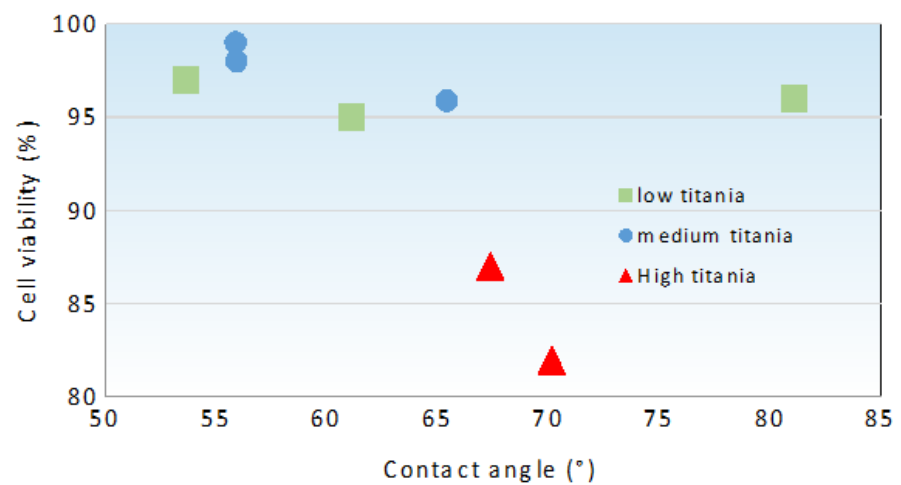
Figure 3. Variation of cell viability with contact angle of investigated ceramics.